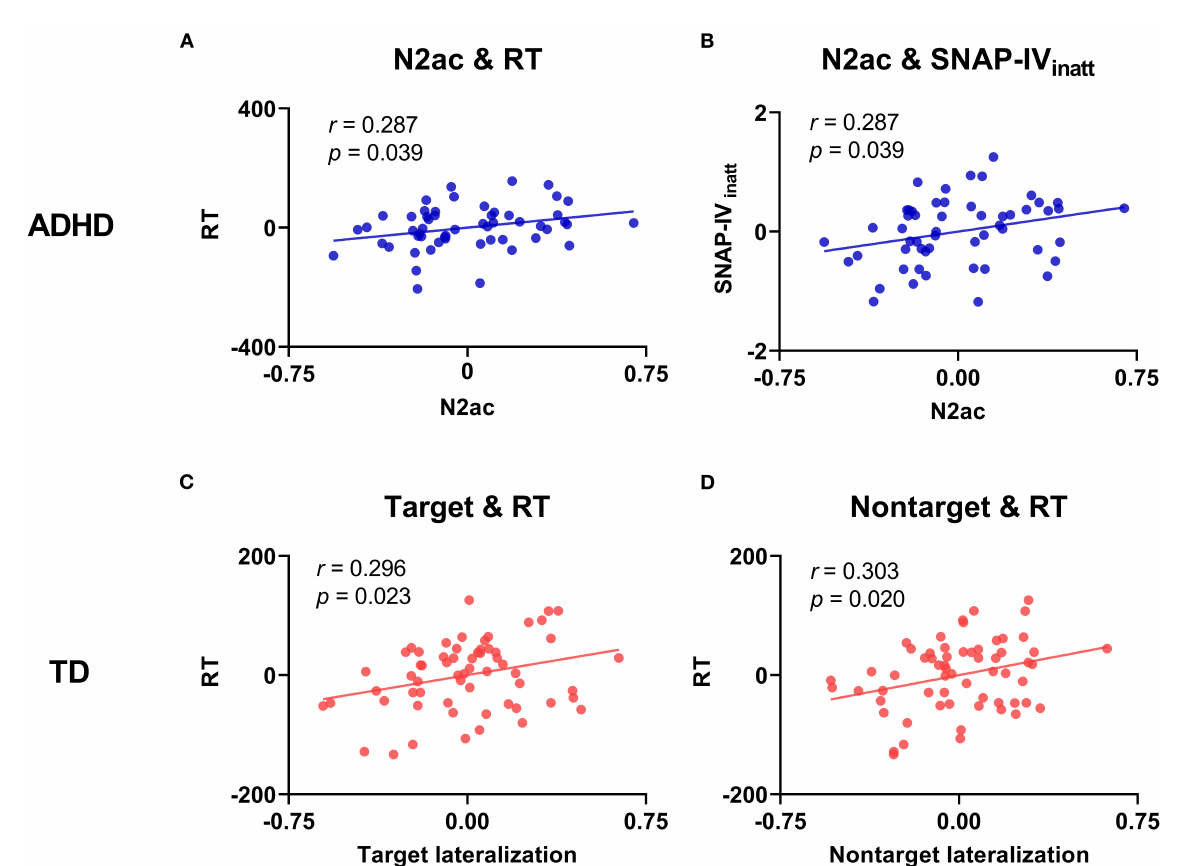
FIGURE6 Scatter plots between the behavioral/clinical data (RT, ERROR, and ADHD symptom score) and EEG data (target lateralization, non-target lateralization, and N2ac component). (A) A significant correlation between the N2ac component and RT in the ADHD group. (B) A significant correlation between the N2ac component and inattention symptom score (SNAP-IV inatt ) in the ADHD group. (C) A significant correlation between target lateralization and RT in the TD group. (D) A significant correlation between non-target lateralization and RT in the TD